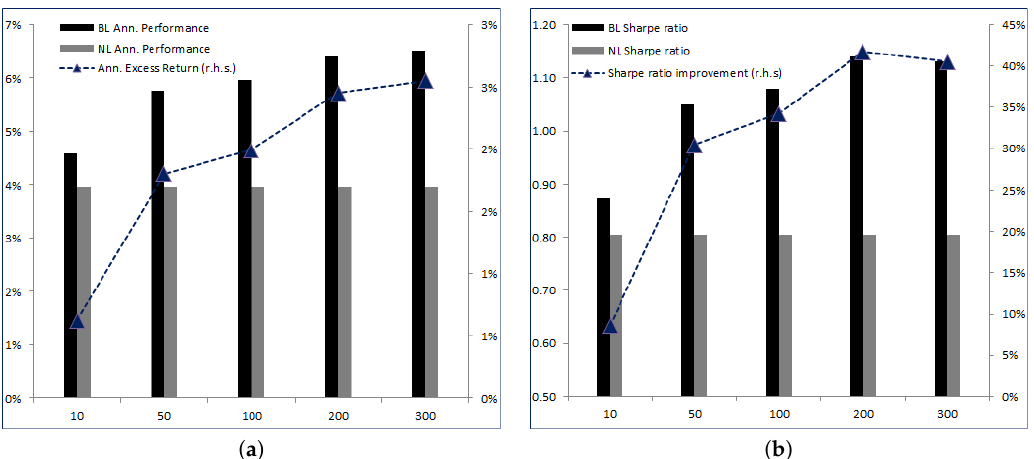
Figure 2. Annualized performances and excess returns of BL as a function of unc ( a ); Sharpe ratios and relative improvement ( b ).